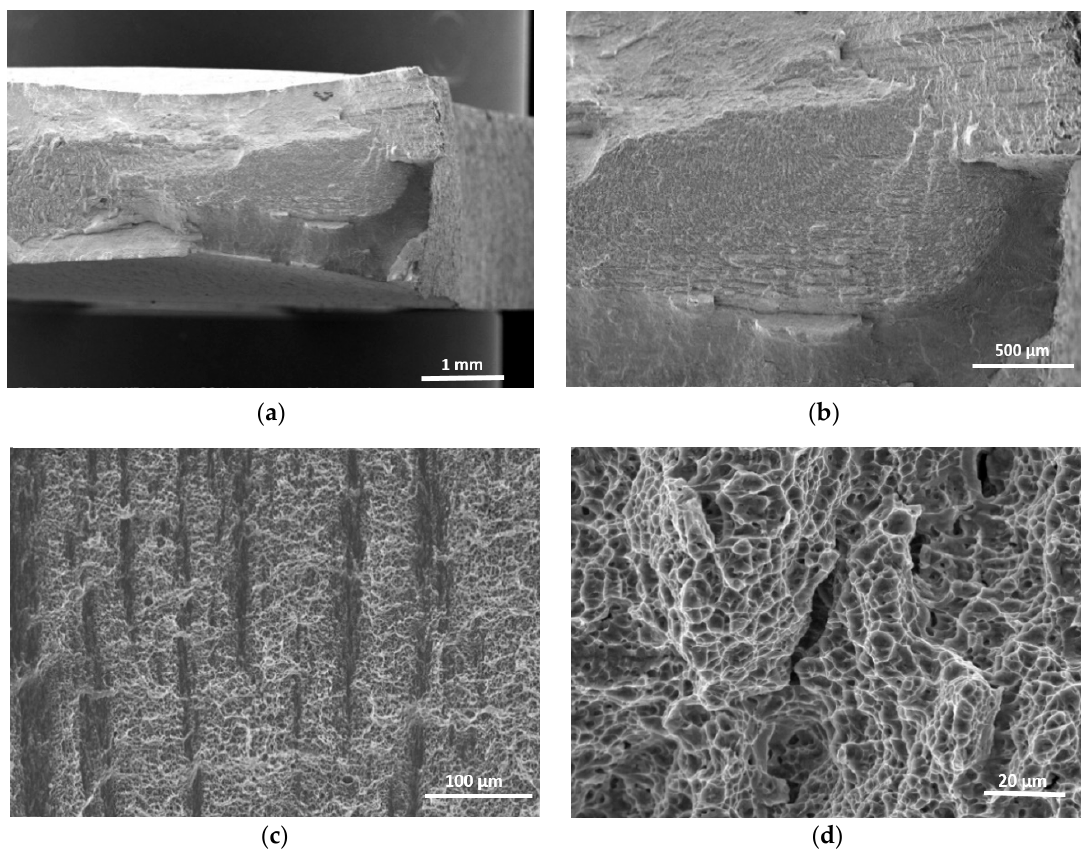
Figure 6. Fracture surface of the specimen from the VT23 alloy previously subjected to impulse loading (curve 27 in Figure 3) obtained at macro ‐ ( a , b ) and micro ‐ ( c , d ) levels.